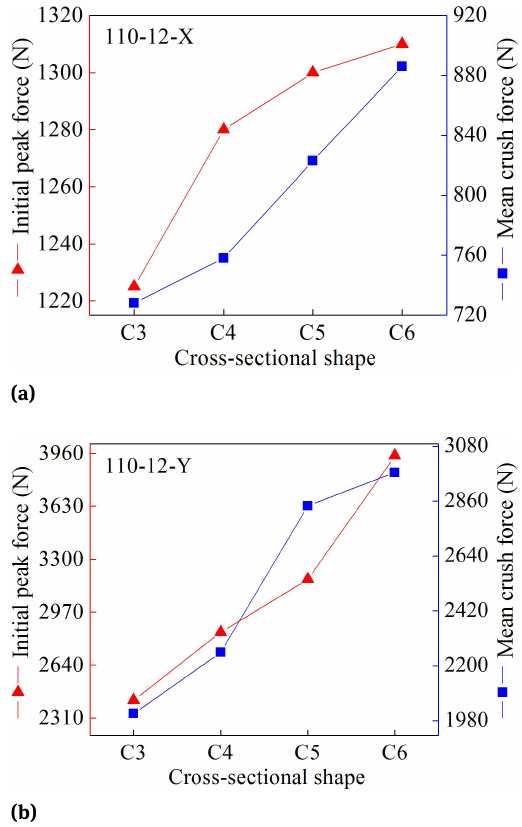
Figure 11: Initial peak force and mean crush force of paper corruga- tion tube: (a) tube along X direction; (b) tube along Y direction